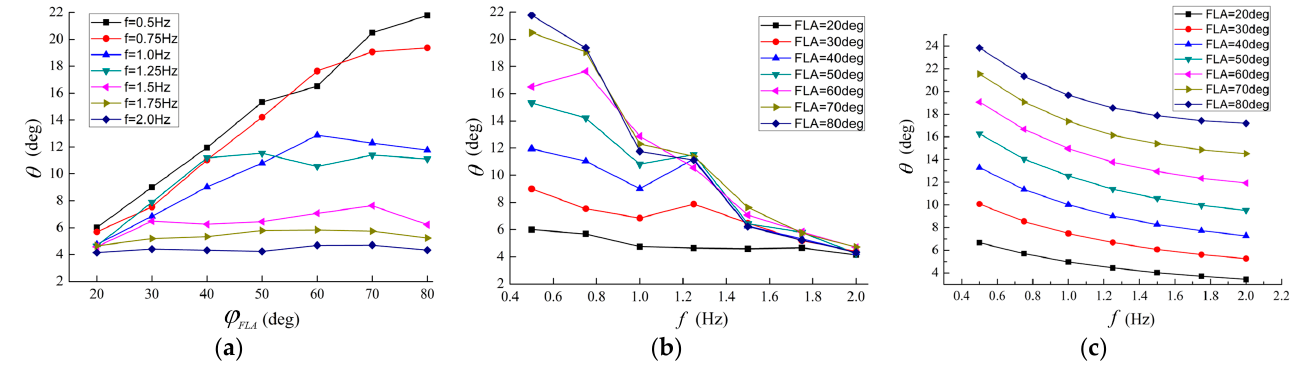
Figure 14. The experiment results of swimming gait 1. ( a ) is the result of the experiment for ϕ FLA ( b ) is the result of the experiment for f . ( c ) is the result of simulation.